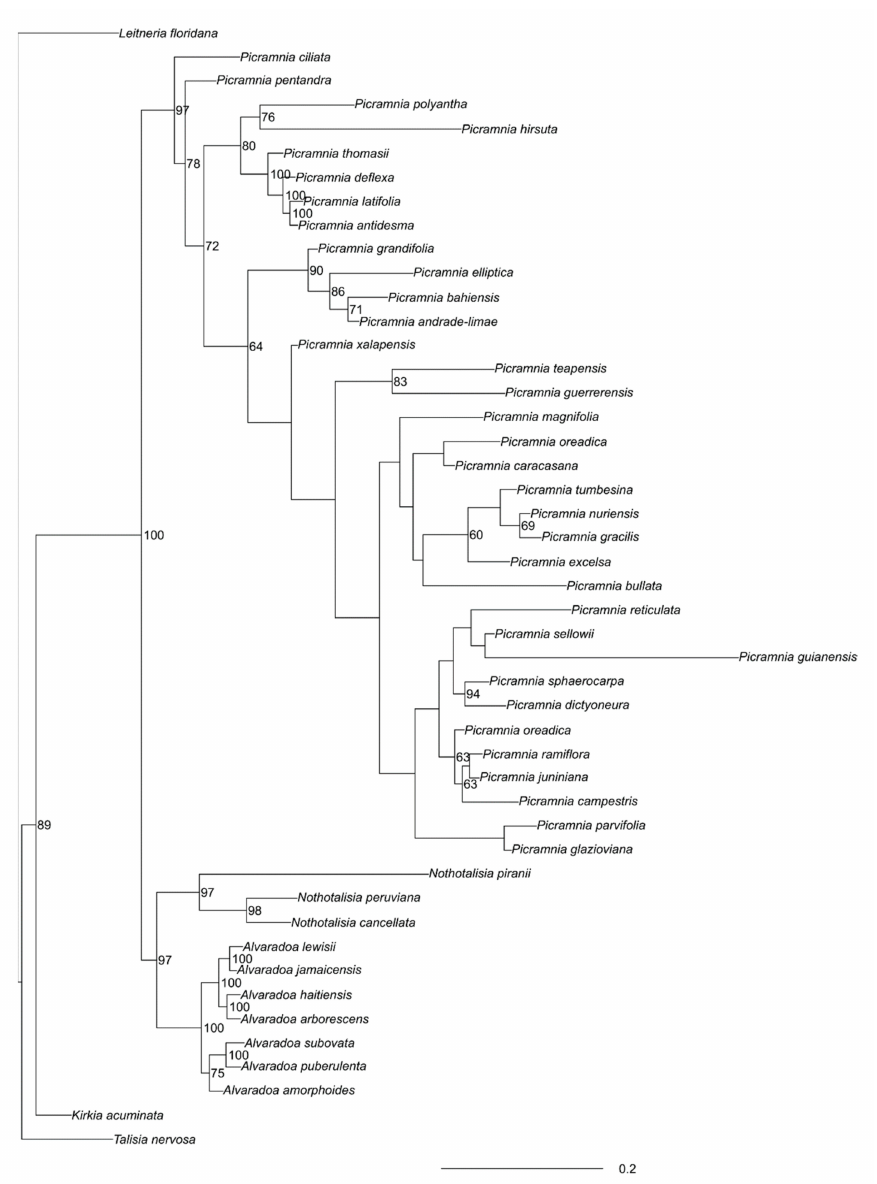
Figure4. MrBayestreeofconcatenated(“semi-strict”)loci.NumbersareBayesiansupport(when ≥